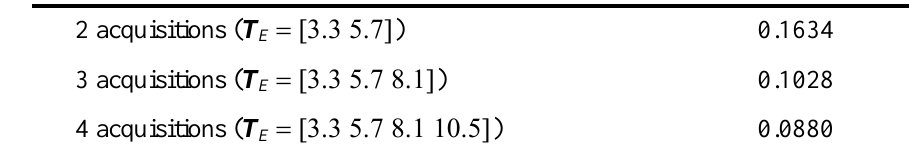
Table 3. Normalized mean square error for different number of available acquisitions—low SNR